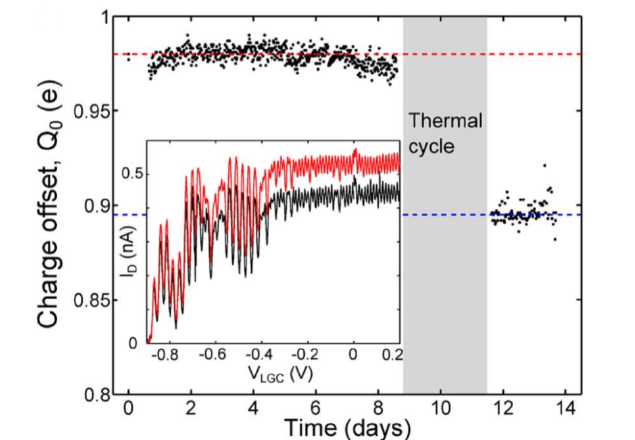
Figure 8. The main panel shows charge offset drift data in an all silicon device with electrostatic barriers. Very stable behavior before and after a thermal cycle to room temperature (represented by the time spanned by the grey bar) is observed. The inset shows the source-drain current as a function of plunger gate voltage before ( black curve) and after ( red curve) the thermal cycle measured with exactly the same voltages on every gate. All features in the data before the thermal cycle are reproduced in the curve taken after the thermal cycle. The curves are offset for clarity. All data were taken at a temperature of about 2.2 K. Reproduced with permission from reference [46], Copyright 2013, Institute of Electrical and Electronics